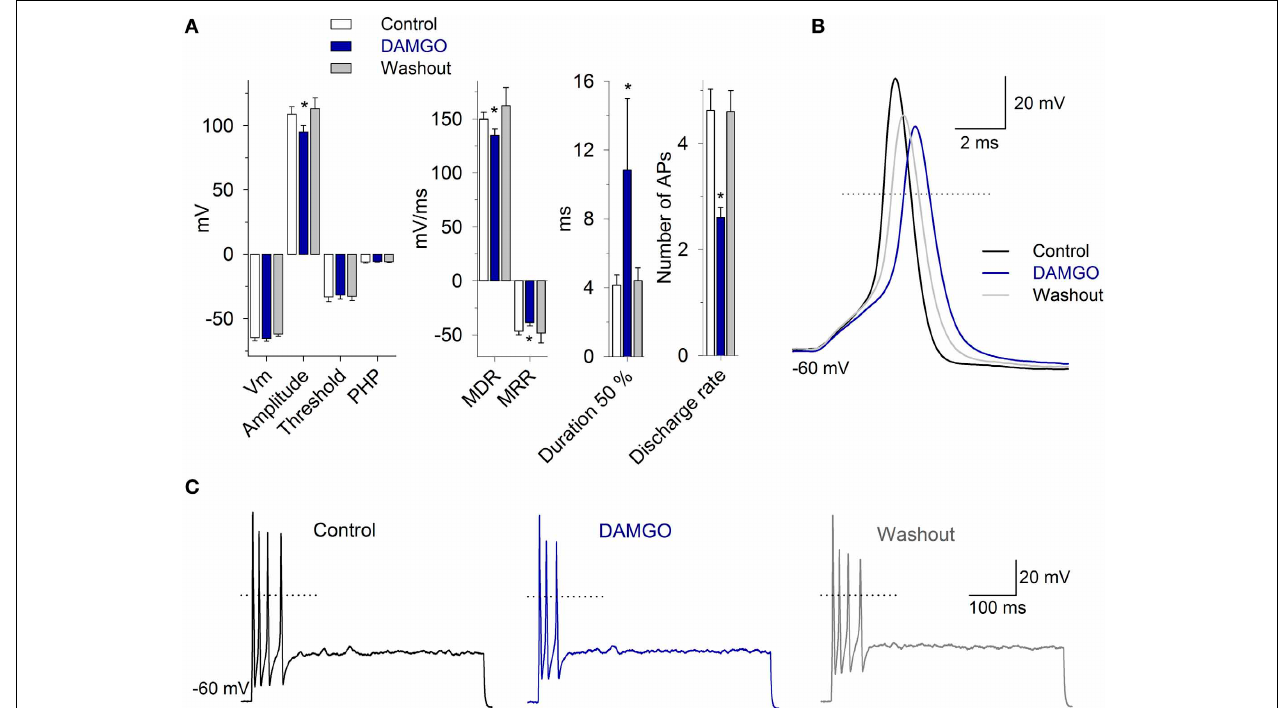
FIGURE 8 | The morphology and discharge of APs are modulated by MOR activation. (A) Bar graph of the AP waveform parameters in the control, with 1 μ M DAMGO and after drug washout ( n = 11). DAMGO increased the AP duration and decreased the amplitude, the MDR and the MRR. (B) Representative AP recordings under the